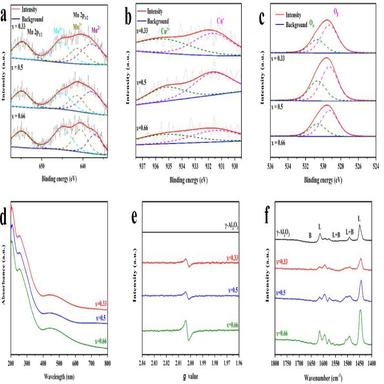
a)-c) XPS spectra for the Mn2p, Cu2p, and O1s regions of the MnxCu1-xOy/γ-Al2O3 catalysts; d) UV–Vis spectrum of the MnxCu1-xOy/γ-Al2O3 samples; e) EPR spectra of the γ-Al2O3 and MnxCu1-xOy/γ-Al2O3 catalysts; f) Py-FTIR spectra of the γ-Al2O3 and MnxCu1-xOy/γ-Al2O3 catalysts after pyridine desorption at 150 °C.